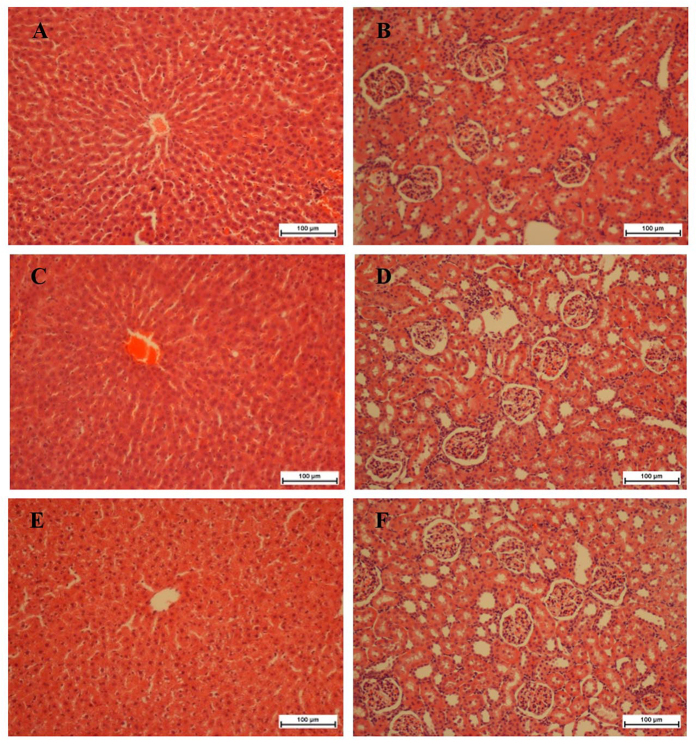
Effect of MDLA on histological sections of the liver and kidney in rats.(A,B) Rats treated with vehicle. (C,D) Rats treated with 500 mg/kg of MDLA. (E,F) Rats treated with 1000 mg/kg of MDLA. There is no significant difference in the architecture of the livers and kidneys between the treated and control groups (H&E stain, 20× magnifications).